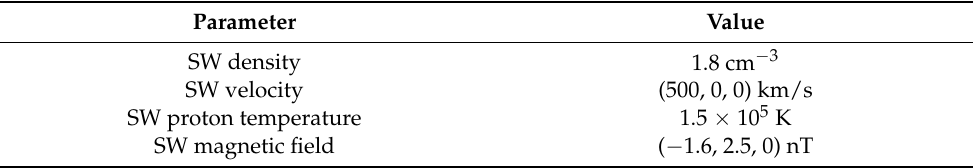
Table 1. Parameters for the MHD